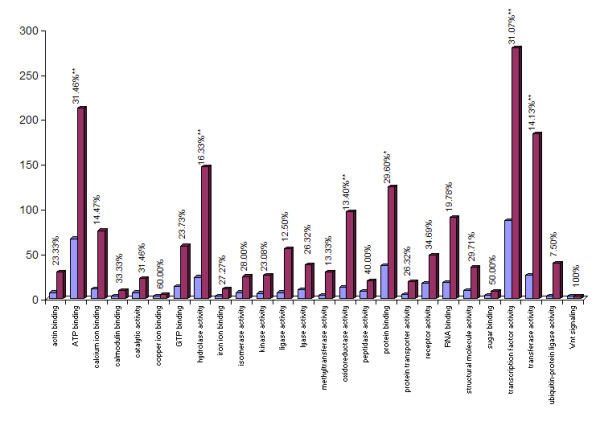
Abundances of gene functions (according to GO) of all fish protein genes with significantly lower or higher distance to the human ortholog than to other fish species (blue) compared to total abundances of gene functions (violet). The percentages represent the rates of the chosen genes compared to the total number of proteins of a given gene function. Significant differences between total and divergent gene abundances according to a χ2-Test are given at the 5% level with one asterisk and at the 1% level with two asterisks.